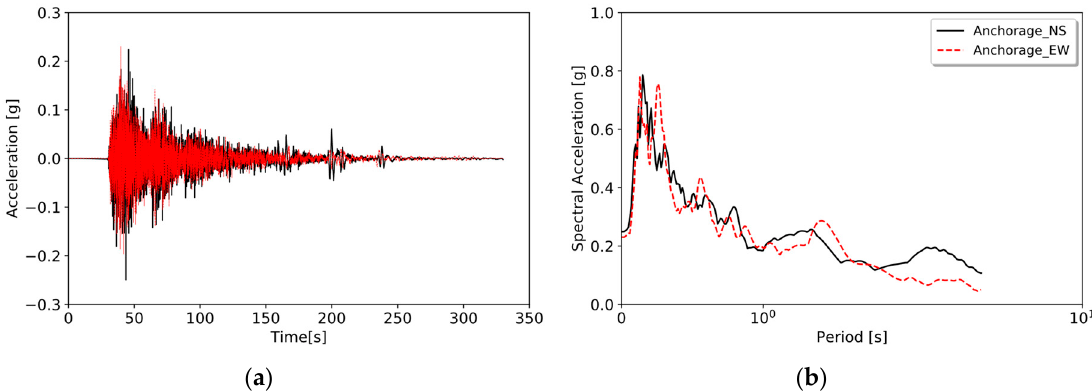
Figure 17. ( a ) Acceleration time-histories of the NS and EW components of the simulated ground motion in Anchorage by Mavroeidis et al. (2008) [40] ( b ) spectral Acceleration (5% damping) of the NS and EW components.